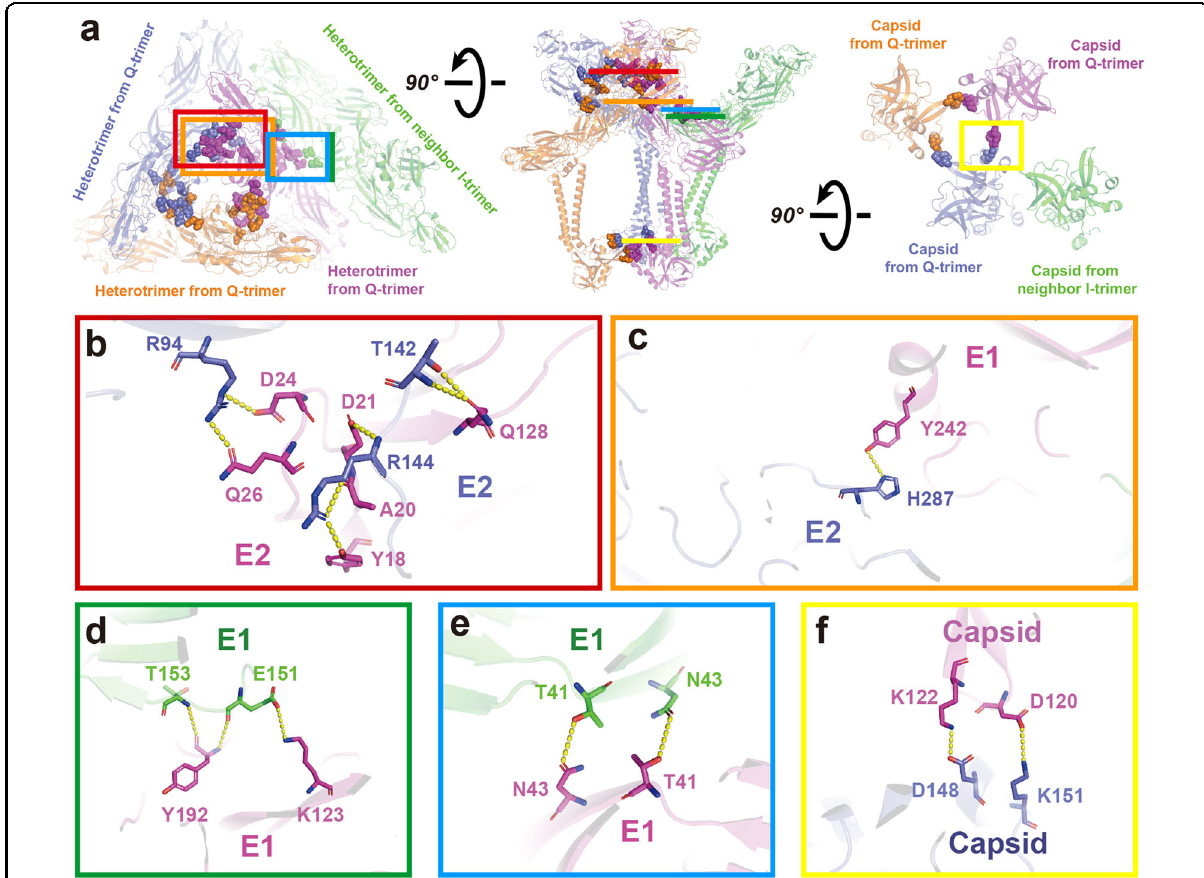
Fig. 3 Interaction of GETV protein domains in the ASU. a The top, side, and bottom view of the ASU. Four E1 – E2 – capsid heterotrimers in the ASU are colored slate, magenta, orange, and green. Residues involved in the interaction are displayed as spheres with the same color as the corresponding heterotrimers. The slate, magenta, and orange heterotrimers form the Q-trimer, and the green heterotrimer is from the neighboring I-trimer. b Zoomed-in view from the red box in a of the interaction between E2 (magenta) and the neighboring E2 (slate) protein. c Zoomed-in view from the orange box in a of the interaction between E1 and the neighboring E2 protein. d , e Zoomed-in views from the green and blue boxes in a , showing the interactions between E1 (magenta) and the neighboring E1 (green), which also represent the interactions between Q-trimer and I-trimer. f The interaction between one capsid protein (magenta) and a neighboring capsid protein (slate) in the Q-trimer. The yellow dashed lines indicate the distance between the atoms involved in the interaction (the cut-off distance is 3.5